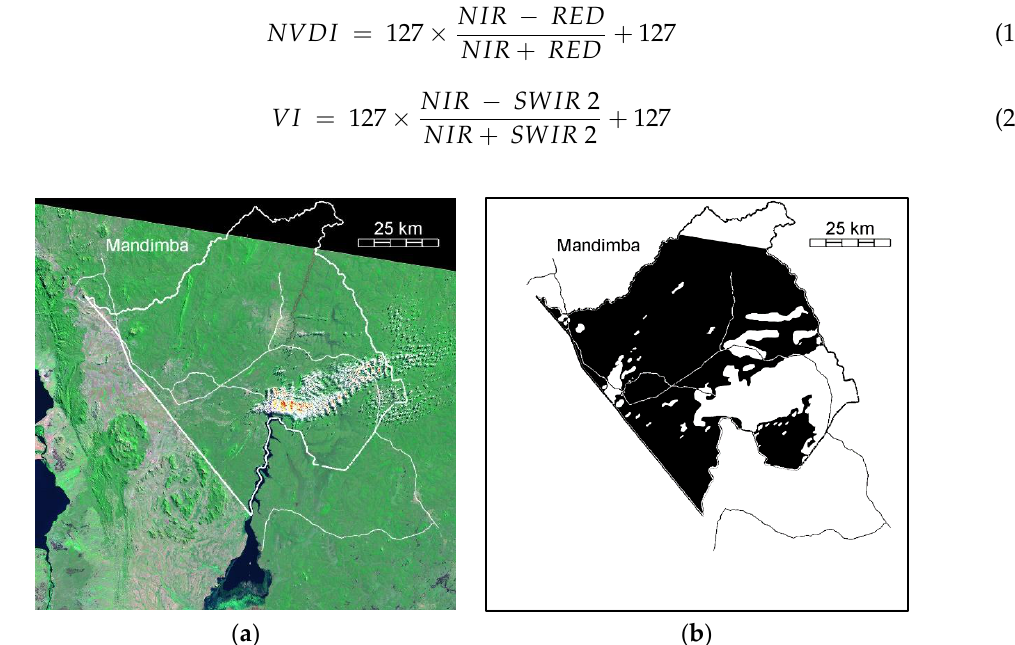
Figure 1. ( a ) Landsat 5 image taken in 1989 over the district of Mandimba (RGB-Bands 743) and ( b ) in black, the mask of the Mandimba district and areas not covered by clouds in the 3 images.